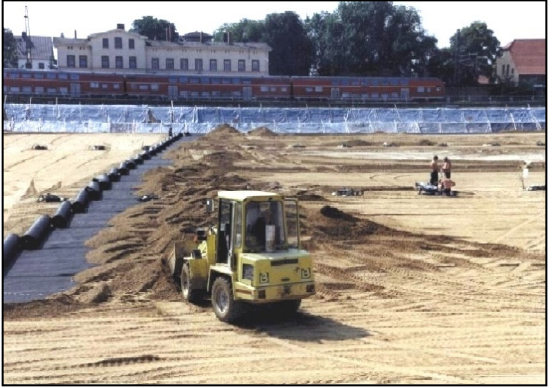
Figure 16. Reinforcement with aramid geosynthetics at the foundation level of the A1 Pyrzowice– Piekary 2011 motorway (shallow mining exploitation and mining faults).